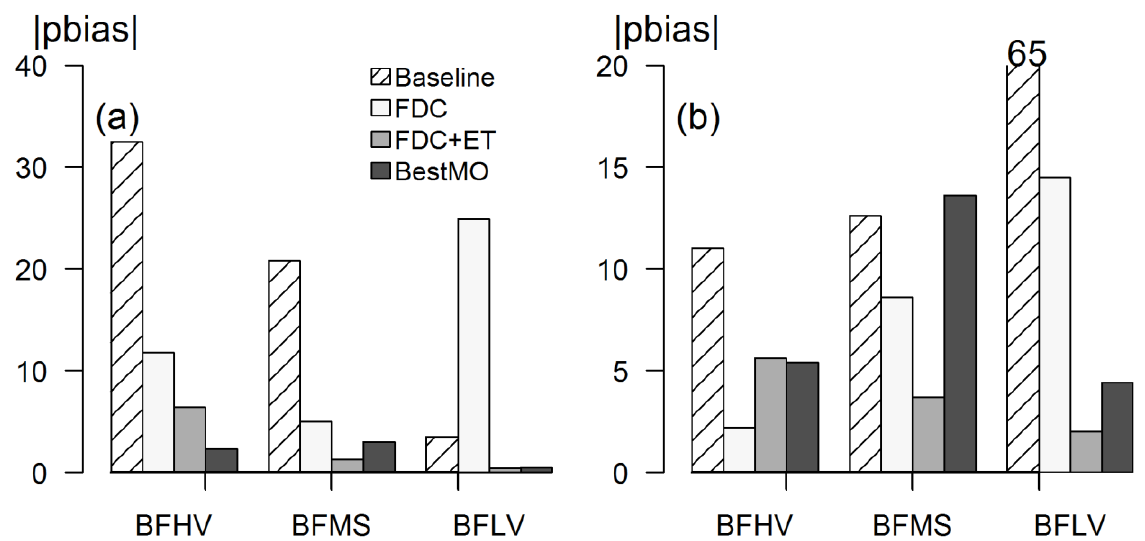
Figure 5. Comparison of normalized mean annual flow duration curves for simulated (2002 – 2007) and observed (1970 – 1990) streamflow for the Nyangores River at Bomet ( a ) and the Mara River at Mara Mines ( b ) using different calibration strategies: uncalibrated (baseline), manually calibrated using only streamflow signatures (FDC) and coupled with evapotranspiration (FDC + ET), automatic multi-objective calibration (bestMO). Note that the y-axis is in log scale.